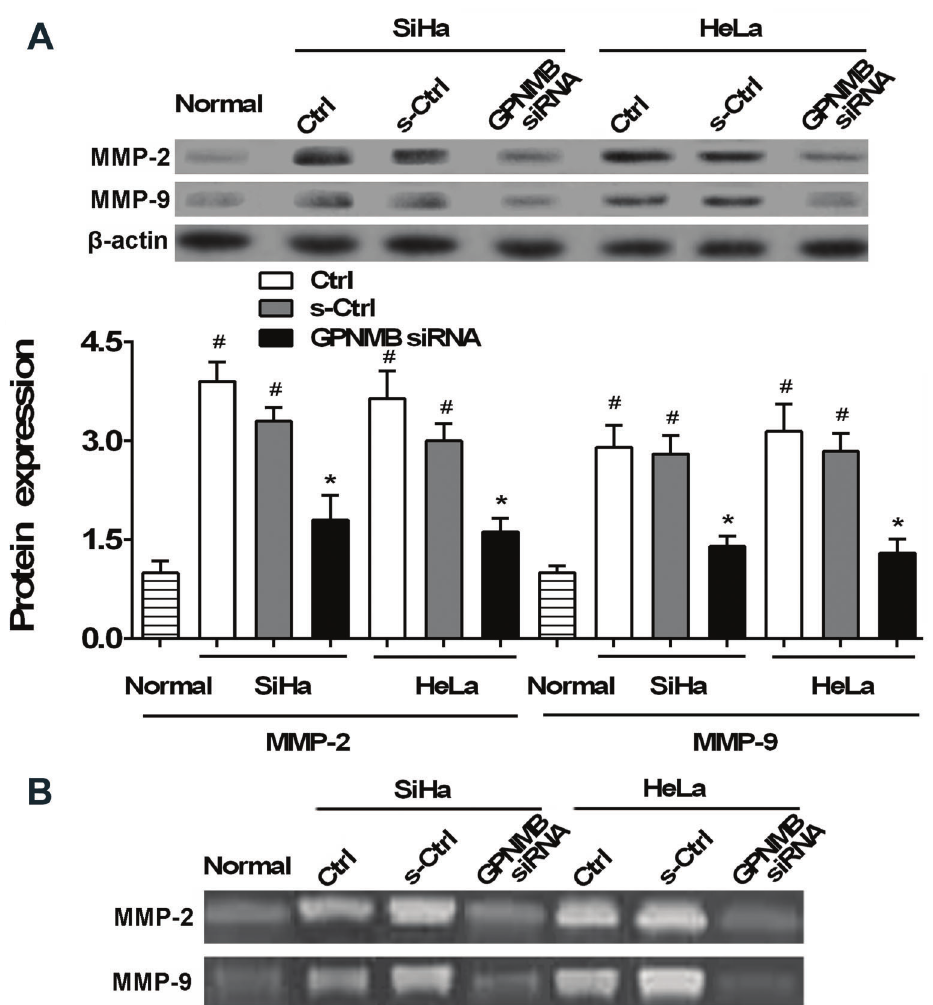
Figure 3. SiHa and HeLa cells were cultured in normal medium (Ctrl), then transfected with glycoprotein nonmetastatic melanoma protein B (GPNMB) siRNA or negative control siRNA (s-Ctrl). A , Expression of MMP-2 and MMP-9 were measured by western blotting in SiHa and HeLa cells as well as in normal cervical epithelial cells (Normal). B , Gelatin zymography assay was performed to evaluate the activity of MMP-2 and MMP-9 in conditioned media of cells. Data are reported as means ± SE. # P o 0.05 vs Normal; *P o 0.05 vs Ctrl